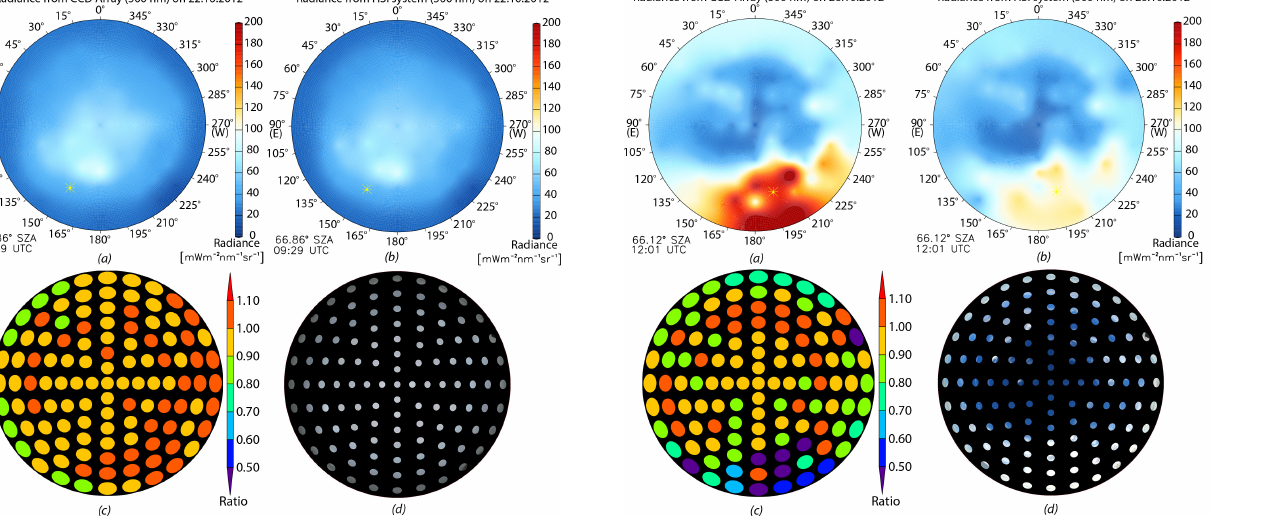
Figure 5. Spectral radiance measured at the wavelength 500nm by the CCD spectroradiometer (a) and HSI system (b) on 22 Octo- ber 2012 at 09:29UCT (66.86 ◦ of SZA) under overcast sky. (c) Ra- tio between the computed spectral radiance from the HSI system and the measured spectral radiance by the CCD spectroradiome- ter (HSI system/CCD spectroradiometer). Although the FOV of the scanning pattern used is 5 ◦ (see d ), the scanning points showing the ratio are plotted with a FOV of 10 ◦ for clarity. The synchronized HSI image showing the 5 ◦ FOV pattern of the scanning points from the CCD spectroradiometer is illustrated in (d) .